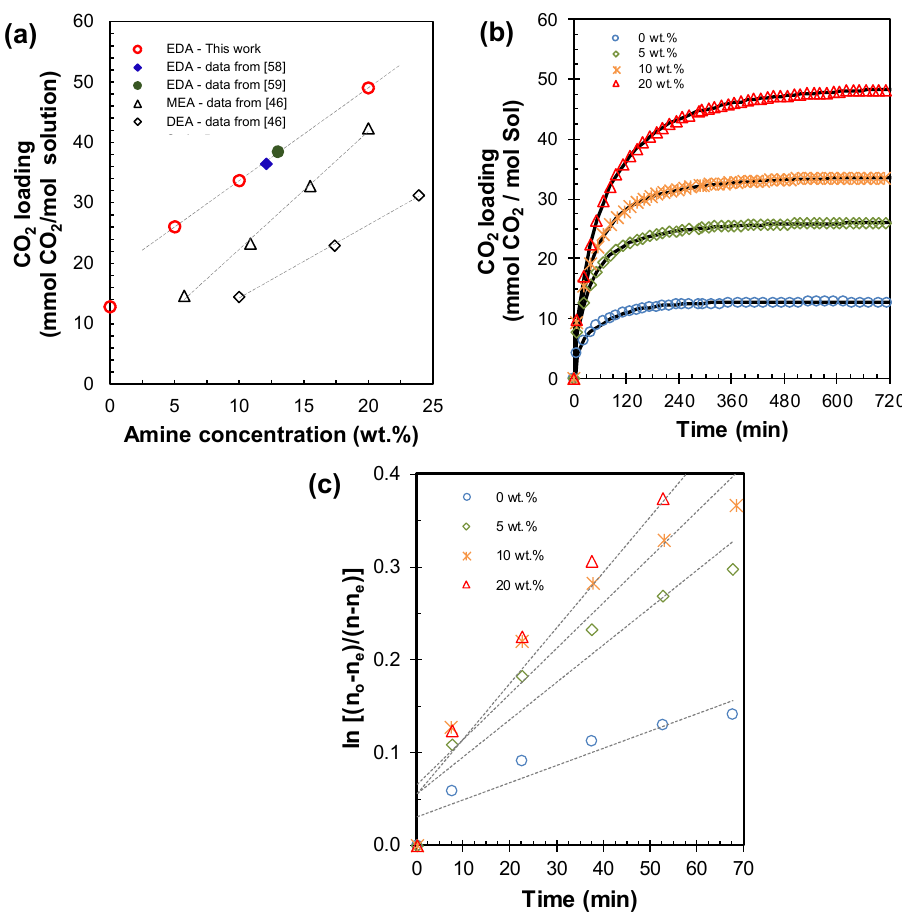
Figure 6. CO 2 capture using EDA—kinetic and thermodynamic analysis: ( a ) CO 2 loading at equilibrium vs. amine concentration; ( b ) CO 2 loading vs. time; ( c ) apparent absorption rate constant at different concentrations.